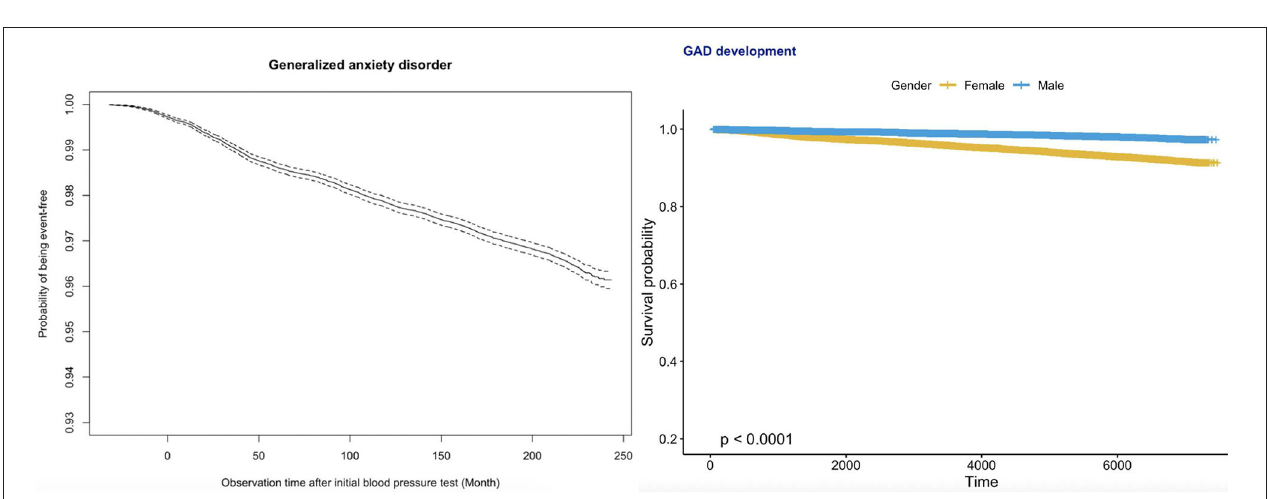
FIGURE 2 | Kaplan–Meier survival curves of incident anxiety development for the whole cohort (top) and stratified by gender (bottom).